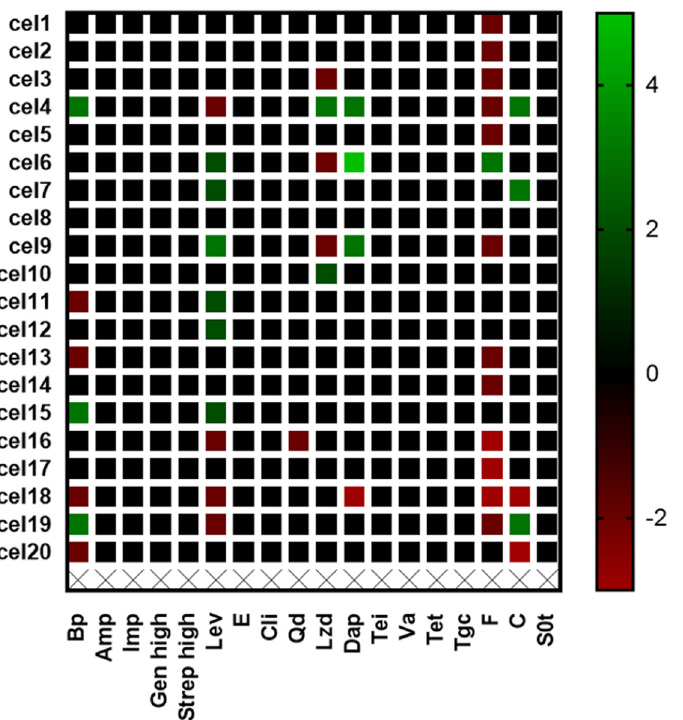
Figure 6. Antibiogram changes after ceviche preparation among L. monocytogenes strains; benzypenicillin (Bp), ampicillin (Amp), high-level gentamicin (Gen High), high-level streptomycin (Strep High), clindamycin (Cli), levofloxacin (Lev), erythromycin (E), quinupristin/dalofopine (Qd), linezolid (Lzd), vancomycin (Va), tetracycline (Tet), tigecycline (Tgc), chloramphenicol (C), daptomycin (Dap), Trimethoprim/sulphamethoxazole (Sxt), and nitrofurantoin (F).